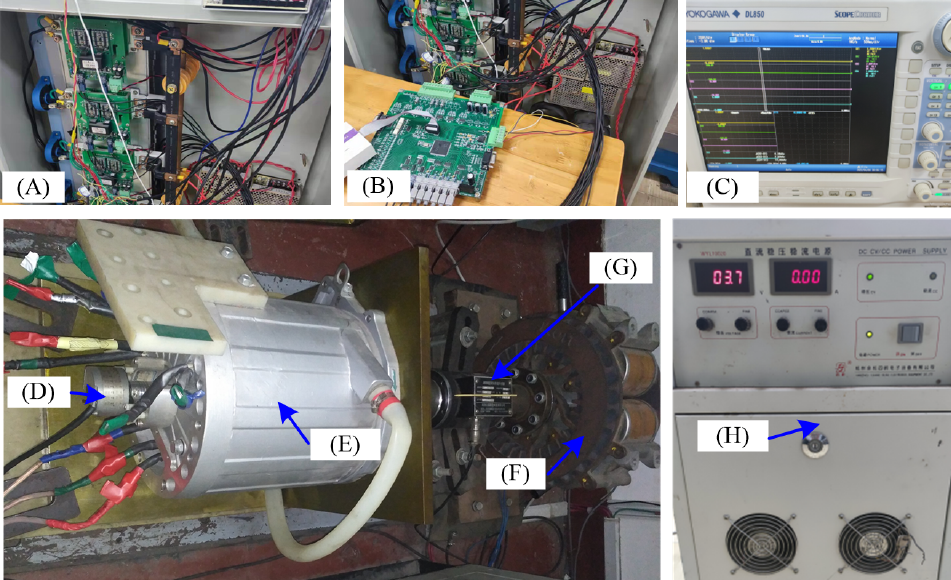
Figure 3. Experimental setup: ( A ) inverter, ( B ) control board, ( C ) oscilloscope, ( D ) encoder, ( E ) IPMSM, ( F ) brake, ( G ) torque transducer, ( H ) DC voltage